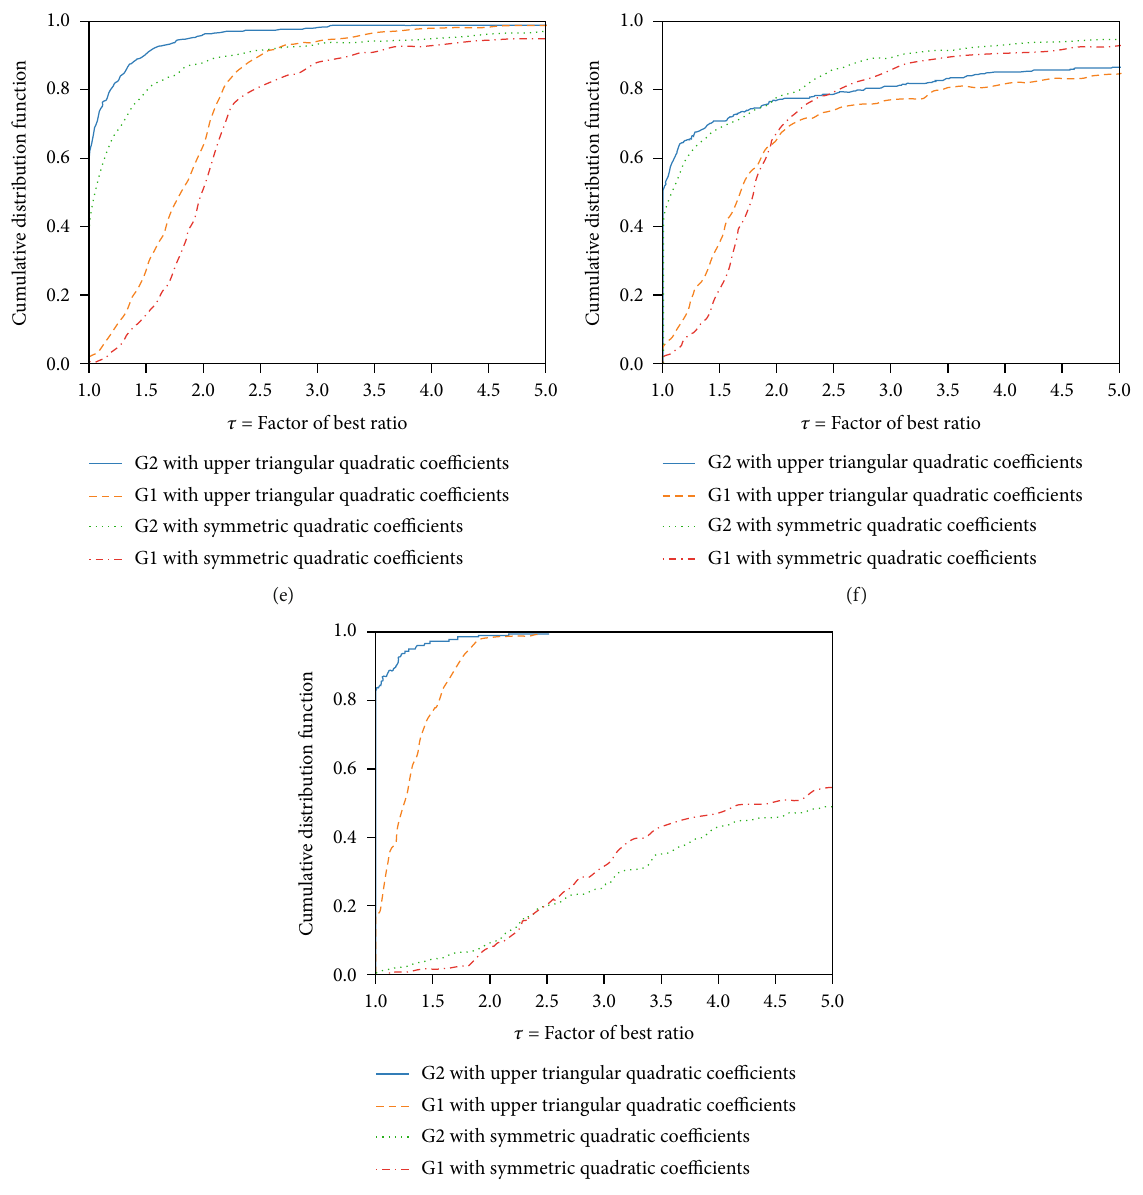
Figure 3: Performance pro fi les based on relative CPU time (s) for Questions 2 and 4. (a) BLSP, (b) QMKP with positive coe ffi cients, (c) QMKP with mixed-sign coe ffi cients, (d) k QKP with positive coe ffi cients, (e) k QKP with mixed coe ffi cients, (f) HSP, (g)